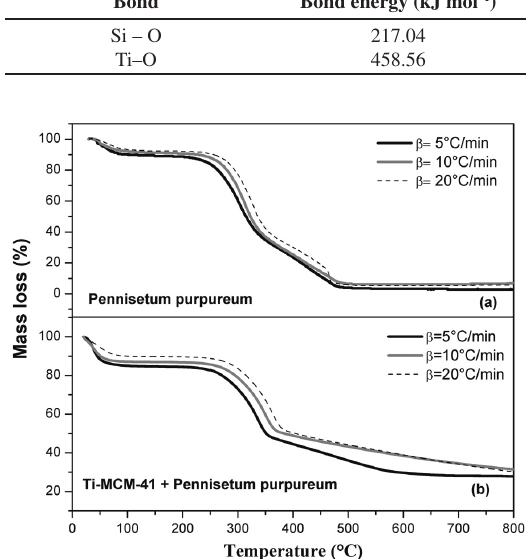
Figure 4. DTG curves of Pennisetum purpureum + Ti-MCM-41 (a) and pure Pennisetum purpureum